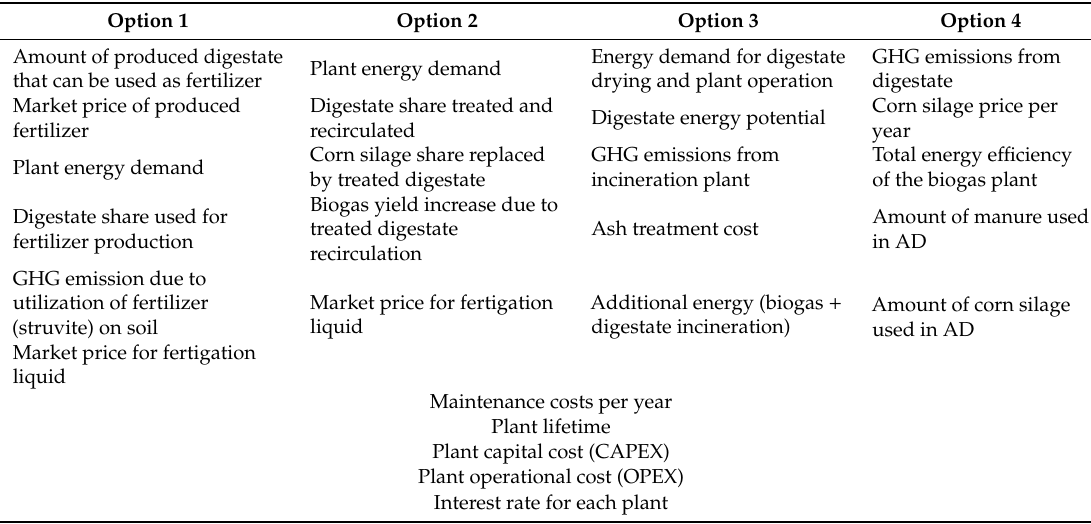
Table 2. Parameters specific for digestate treatment